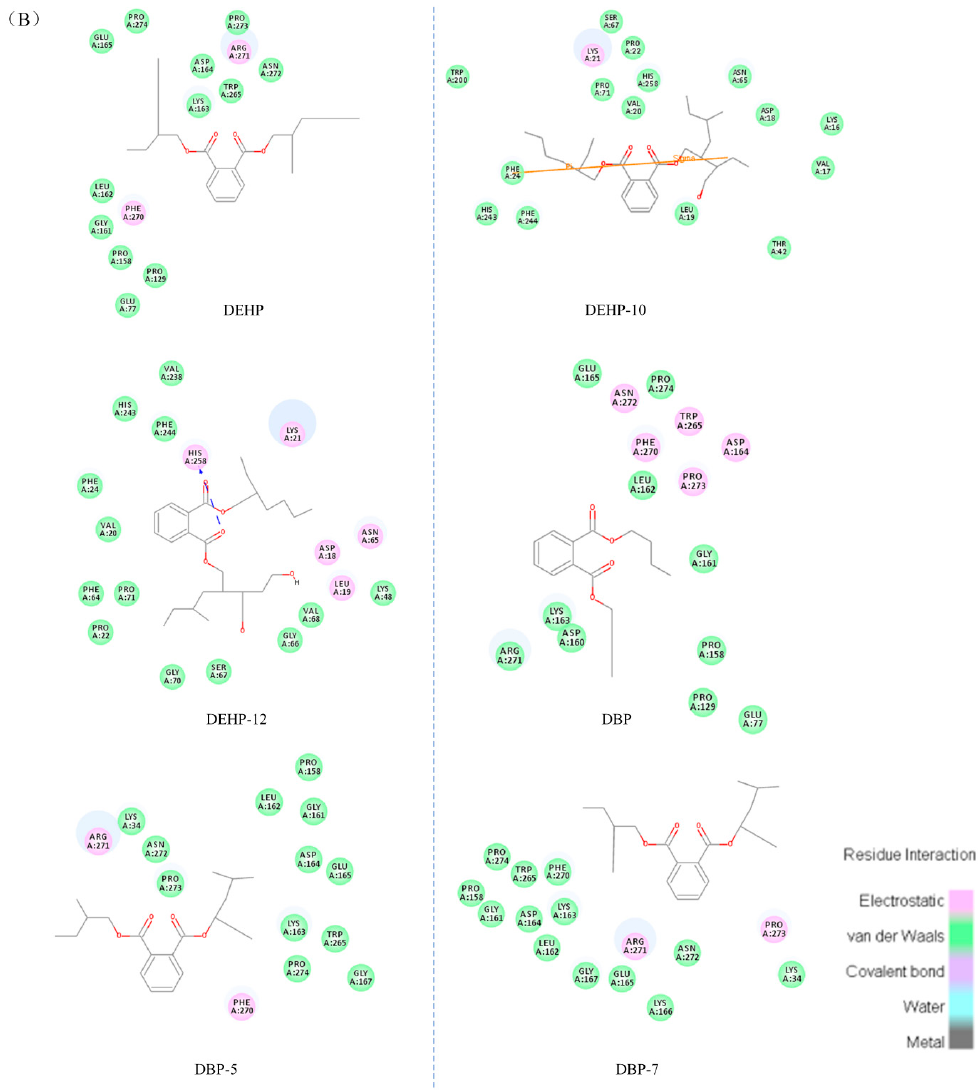
Figure 3. Amino acid residue map of the PAE substitutes binding to aerobic bacteria ( A )/anaerobic bacteria ( B ) degradable complex proteins.